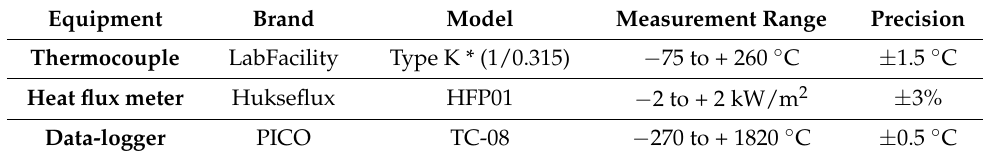
Table 4. Equipment used in the HFM thermal conductivity tests [41].